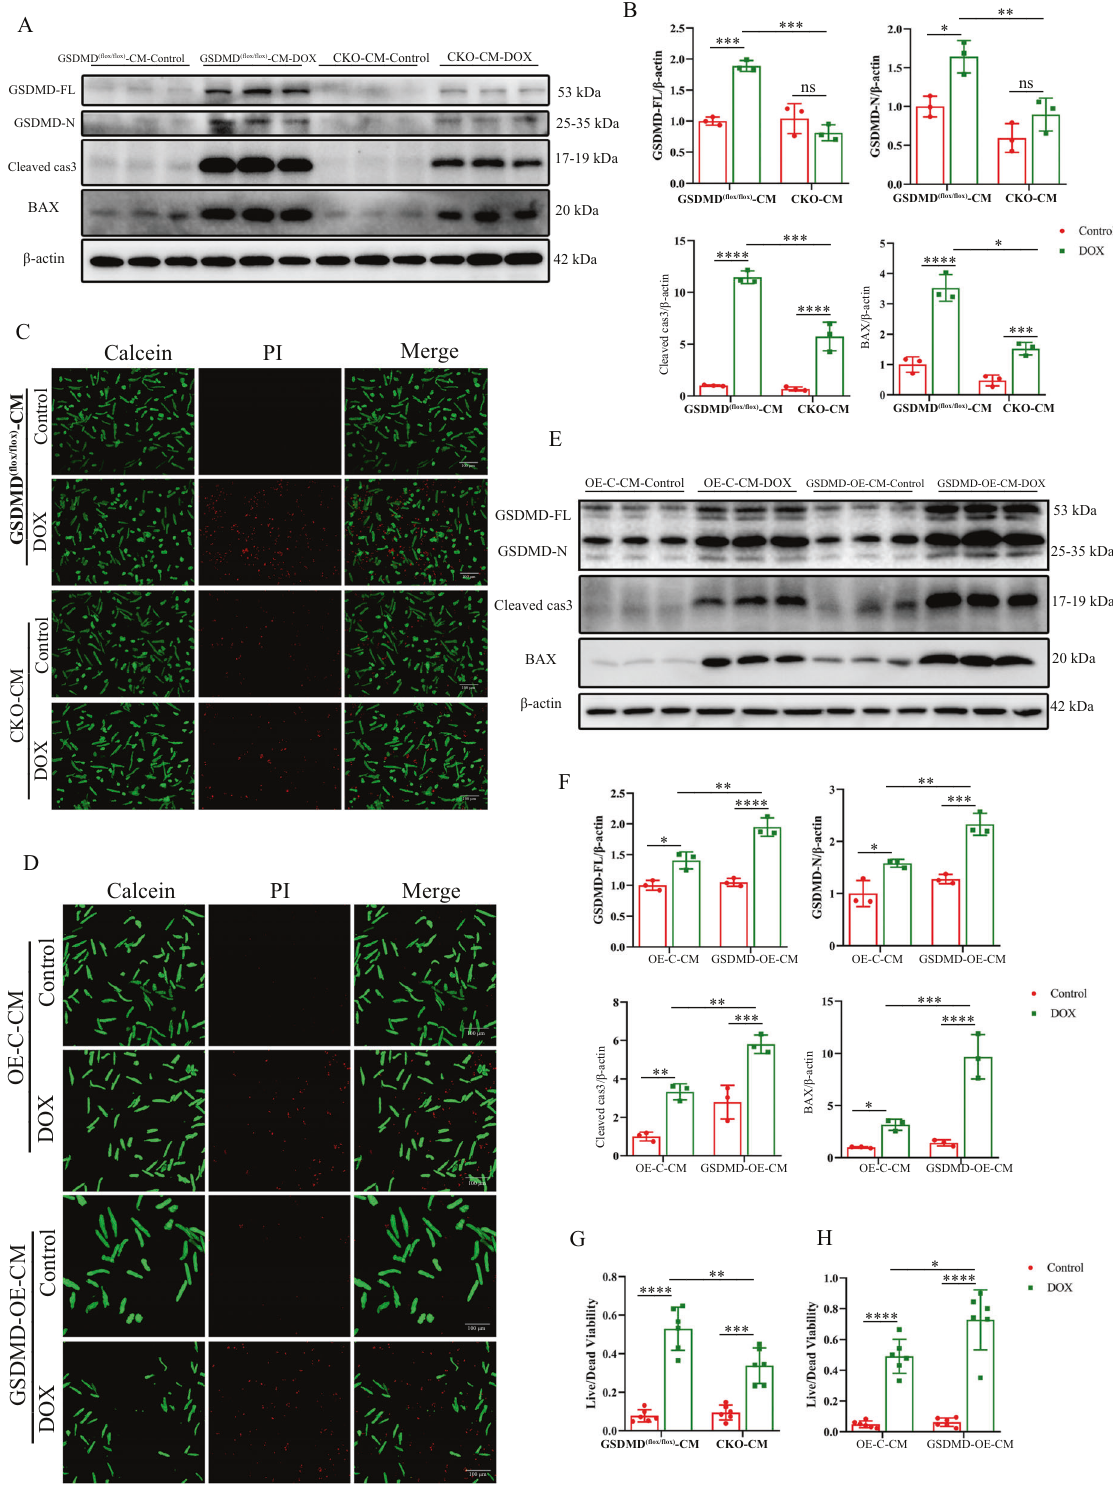
Fig. 3 GSDMD de fi ciency causes apoptosis in cardiomyocytes and exacerbates DIC. A , B GSDMD-FL, GSDMD-N, Cleaved-caspase 3 (Cleaved cas3) and BAX were measured using western blot assay, and relative band density was quanti fi ed. N = 3 per group. C , G Cell viability was determined using PI staining, and the live-to-dead cell ratios of GSDMD ( fl ox/ fl ox) and GSDMD-CKO cardiomyocytes were quantitated (scale bar: 100 μ m). N = 6 per group. E , F The protein levels of GSDMD-FL, GSDMD-N, cleaved-caspase 3 (Cleaved cas3), and BAX in OE-C and GSDMD-OE cardiomyocytes treated with saline or DOX. N = 3 per group. D , H Cell viability was determined using PI staining, and the live-to-dead cell ratios of OE-C and GSDMD-OE cardiomyocytes were quantitated (scale bar: 100 μ m). N = 6 per group. Data are depicted as the mean ± SEM. Statistical signi fi cance was determined by one-way and two-way ANOVA with a post hoc Holm – Sidak test, ns, not signi fi cant; * P < 0.05; ** P < 0.01; *** P < 0.001; **** P <